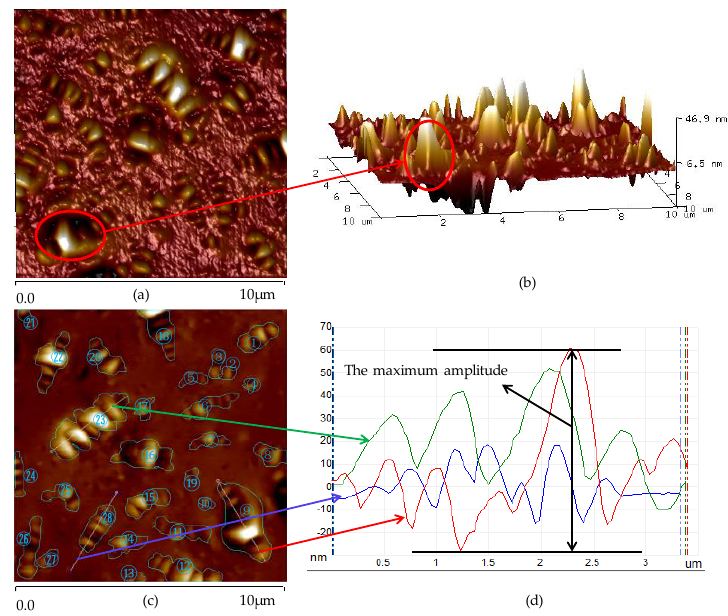
Figure 4. Bitumen AFM images. ( a ) two-dimensional height images; ( b ) three-dimensional height images; ( c ) bee-like structure analysis images; ( d ) maximum amplitude.